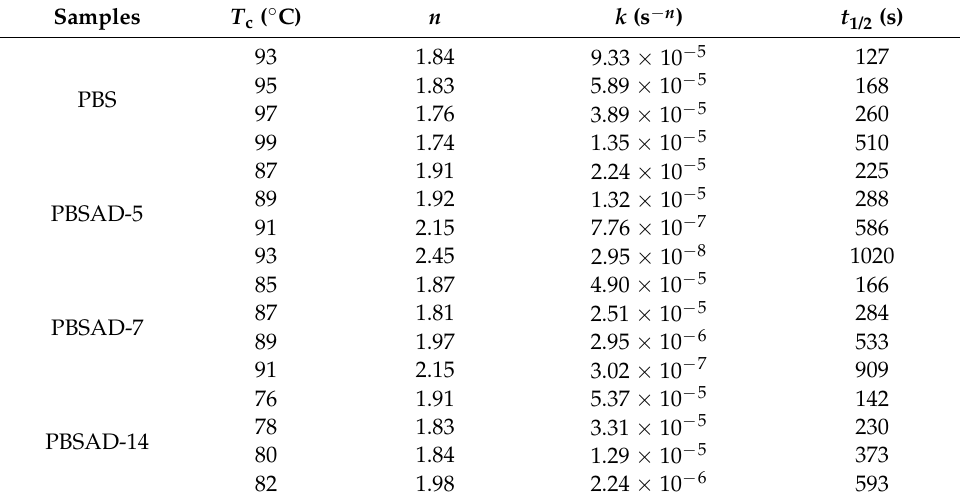
Table 2. Isothermal crystallization kinetics parameters of PBS and PBSAD. Samples